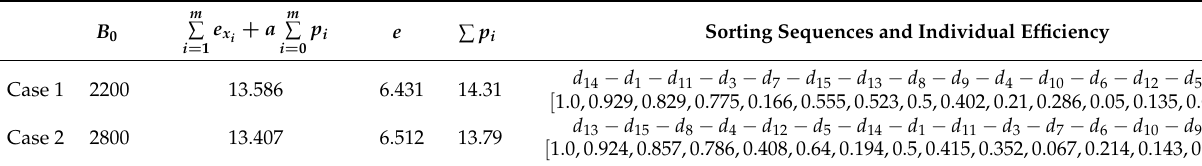
Table A6. Solutions of sorted negotiation Model (20).